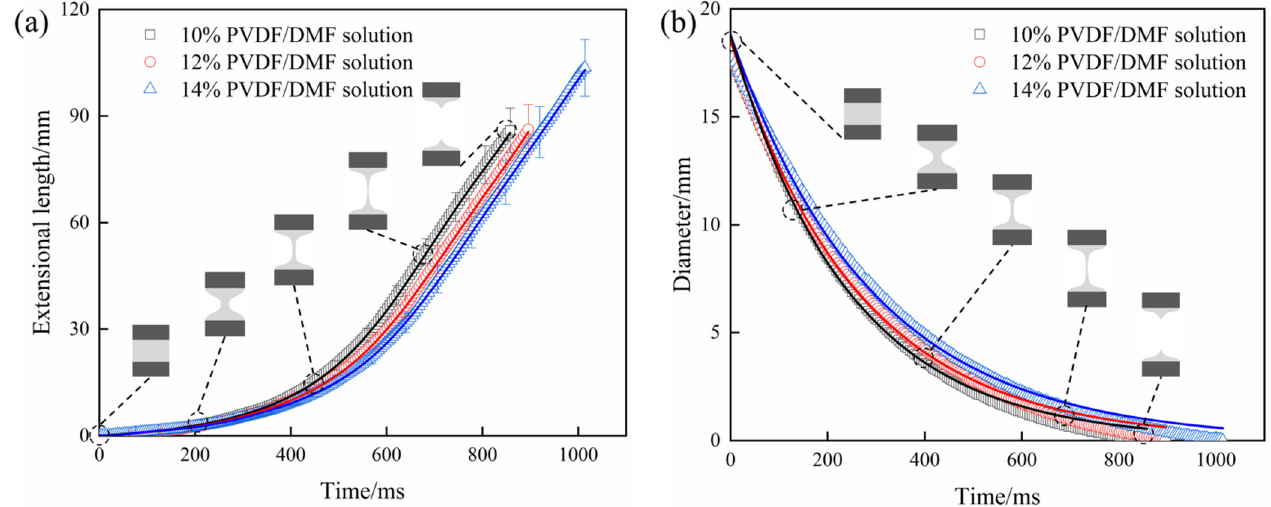
Figure 5. The size of PVDF/DMF liquid column: ( a ) extensional length and ( b ) minimum diameter at medium height.